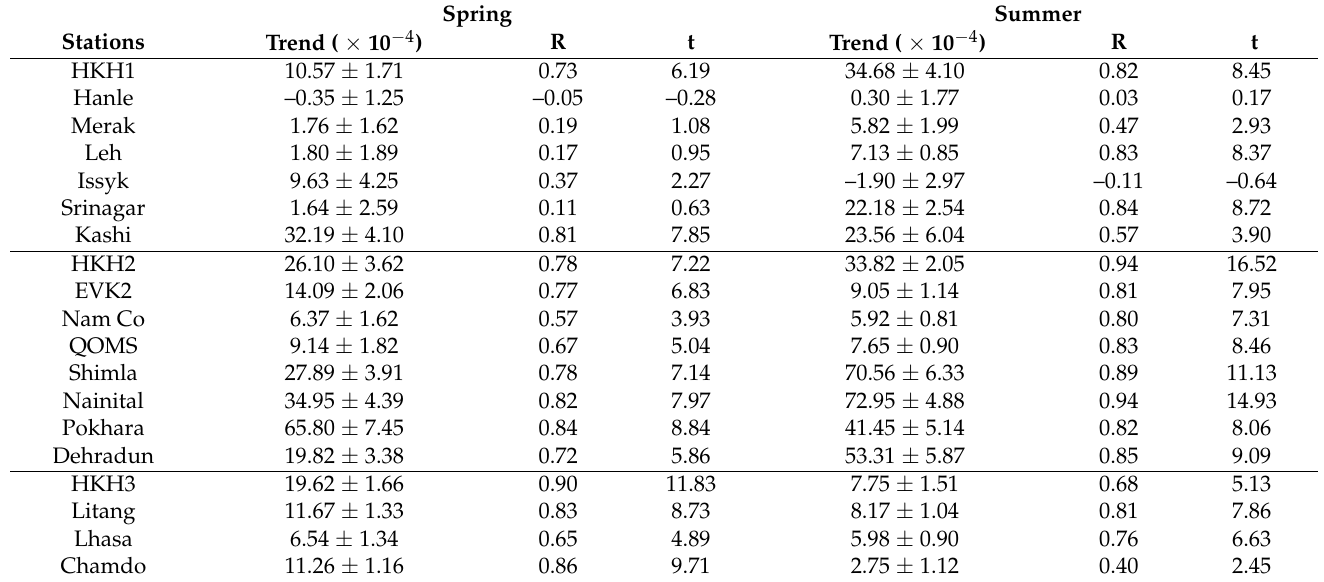
Table 4. Seasonal (Spring and Summer) AOD trend (AOD year − 1 ), t and R values at different sub-regions in the Hindu Kush Himalayan region during 1980–2020 in the present study. Spring Summer